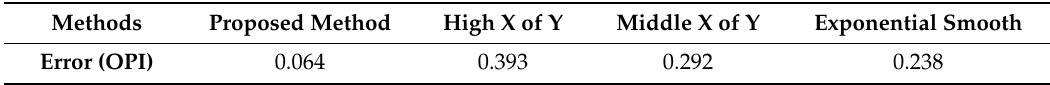
Table 2. Error (Overall Performance Index (OPI)) per